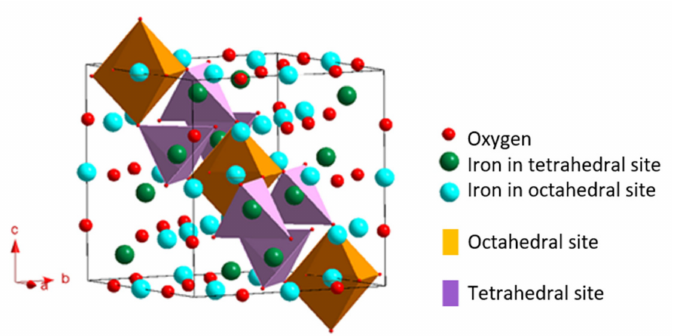
Figure 1. Representation of mesh of the crystallographic structure of magnetite. The octahedra and tetrahedra materialize on of the planes (111) of the